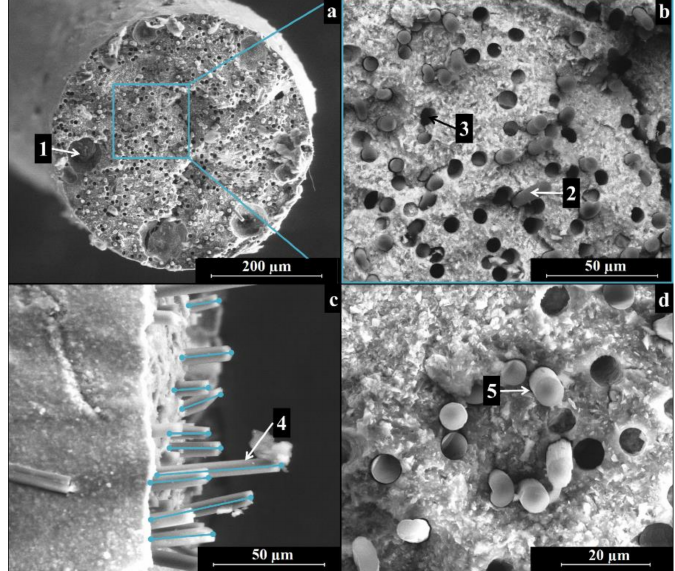
Figure 6. SEM images of a pyrolyzed filament produced with Ink B using a 580- µ m nozzle: ( a ) an overview of the cross-section; ( b ) homogeneous fiber and filler distribution in the filament; ( c ) fiber alignment and pull out; ( d ) close up of the interface between fibers and matrix. Legend: (1) air voids; (2) carbon fibers; (3) voids left by carbon fibers pulled-out during fracture; (4) fiber pull-out; (5) interface between matrix and